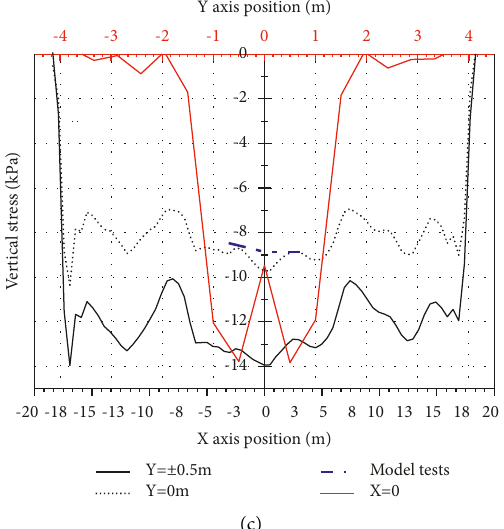
Figure 18: Comparison of model test and results: (a) Physical picture of model. (b) Schematic diagram of cross section of model test. (c) Comparison curve of vertical stress distribution on the upper surface of bed